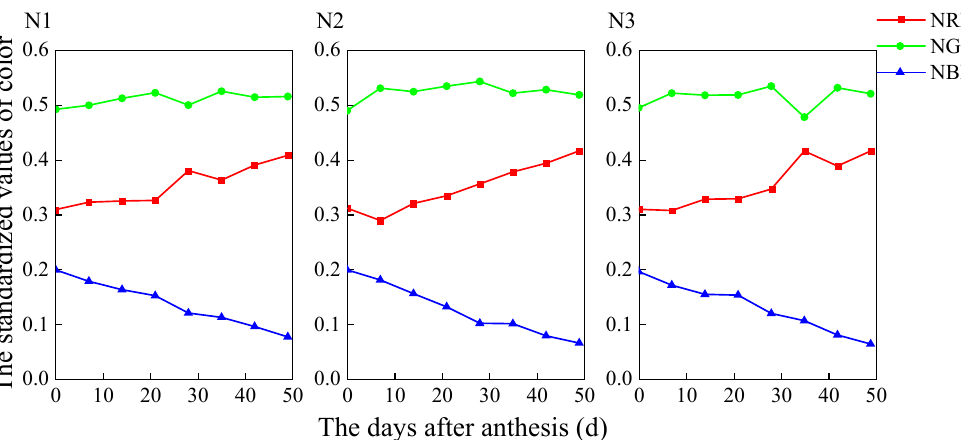
9 of 20 Table 5. Fitting equations of RGB components of leaves after anthesis—different varieties with different nitrogen levels (y = ae bx , y = a + bx). Variety